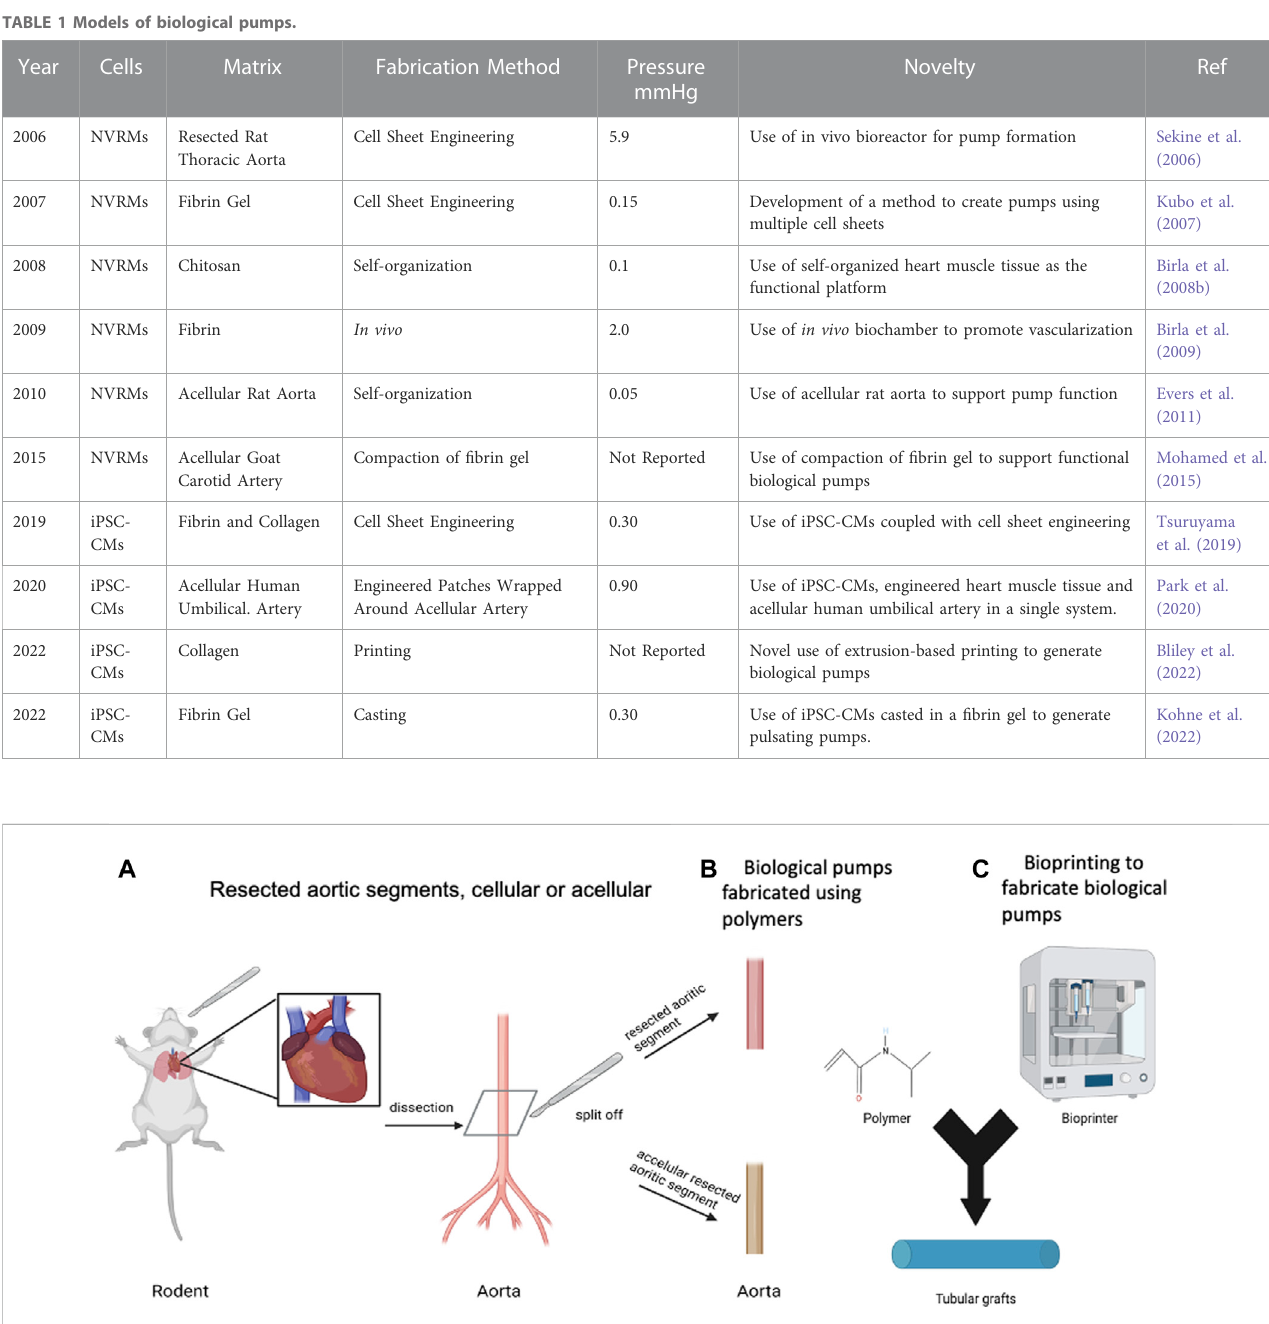
Frontiers in Bioengineering and